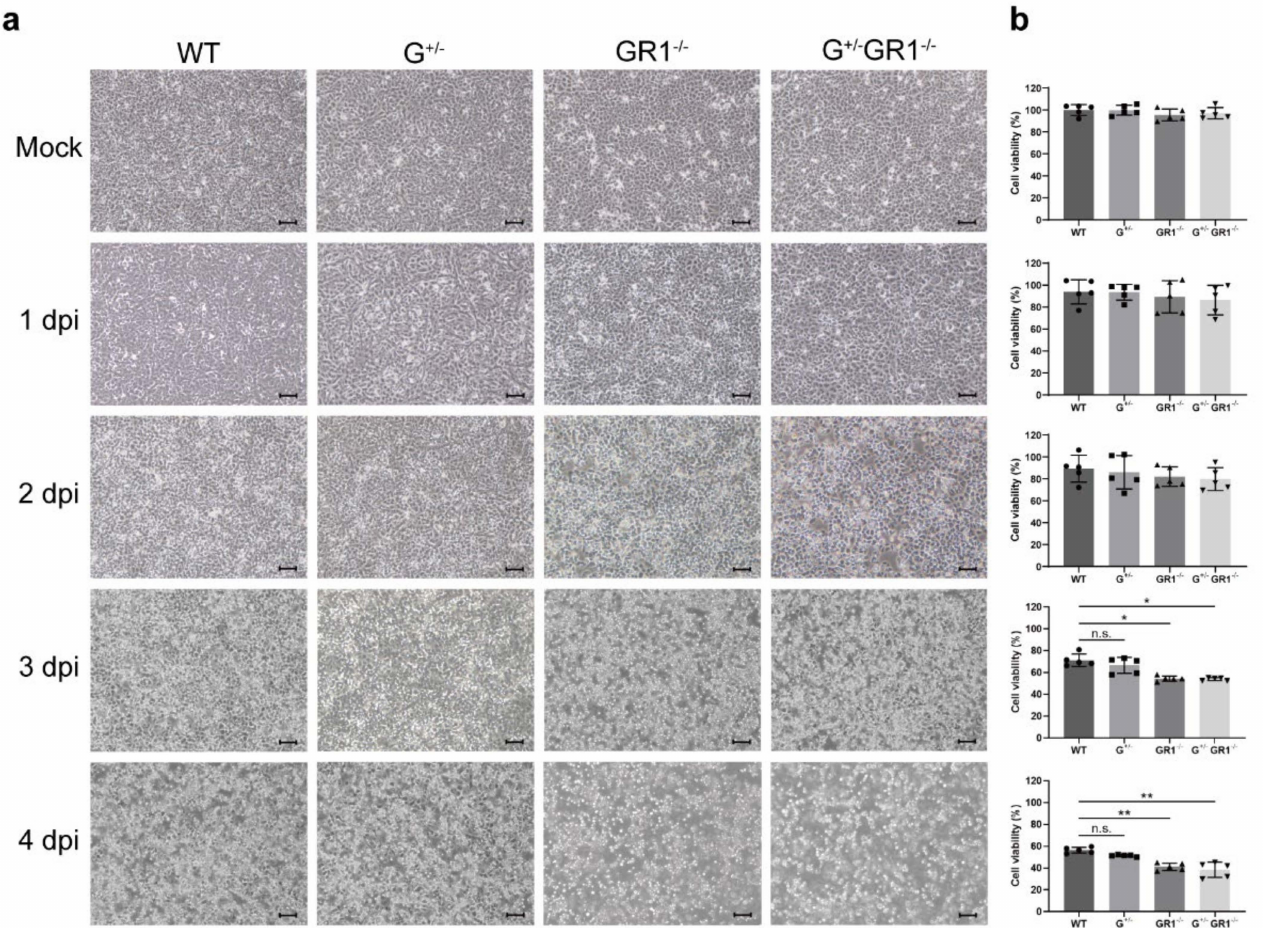
Figure 5. Susceptibility of IFNG - and IFNGR1 -knockout Vero cell lines to infection by HcoV-OC43 virus. ( a ) Microscopic analysis of cytopathic effects in G +/ − , GR1 − / − , and G +/ − GR1 − / − cell lines infected with HCoV-OC43 compared with infected wild-type cells. Cytopathic effects were monitored daily using a light microscope, and photographs of cell monolayers were captured every 24 h after infection. Representative images are shown from independent triplicates. Scale bars: 10 µ M (applies to all images). ( b ) Viability of G +/ − , GR1 − / − , and G +/ − GR1 − / − cell lines after HCoV-OC43 infection compared with that of wild-type cells. Cell viability, assessed by MTT assay, was normalized to that of uninfected wild-type controls. Results are shown as means ± SD of five independent replicates (* p < 0.05; ** p < 0.01; n.s., not